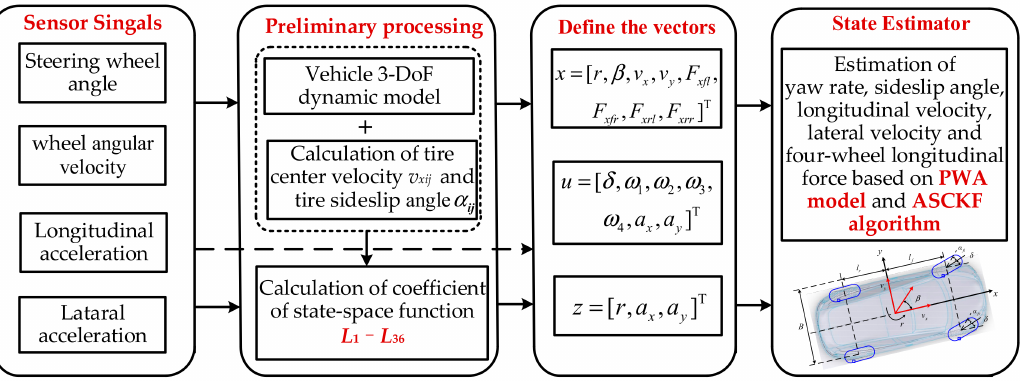
Figure 6. The overall framework for the estimation